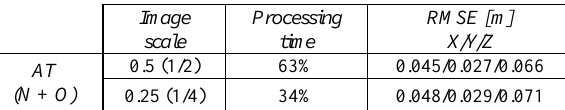
Table 3. Processing time of AT, when tie point extraction is performed at 0.5 and 0.25 image scales. Time is represented in % with respect to full-size images (image scale 1, as reported in Table